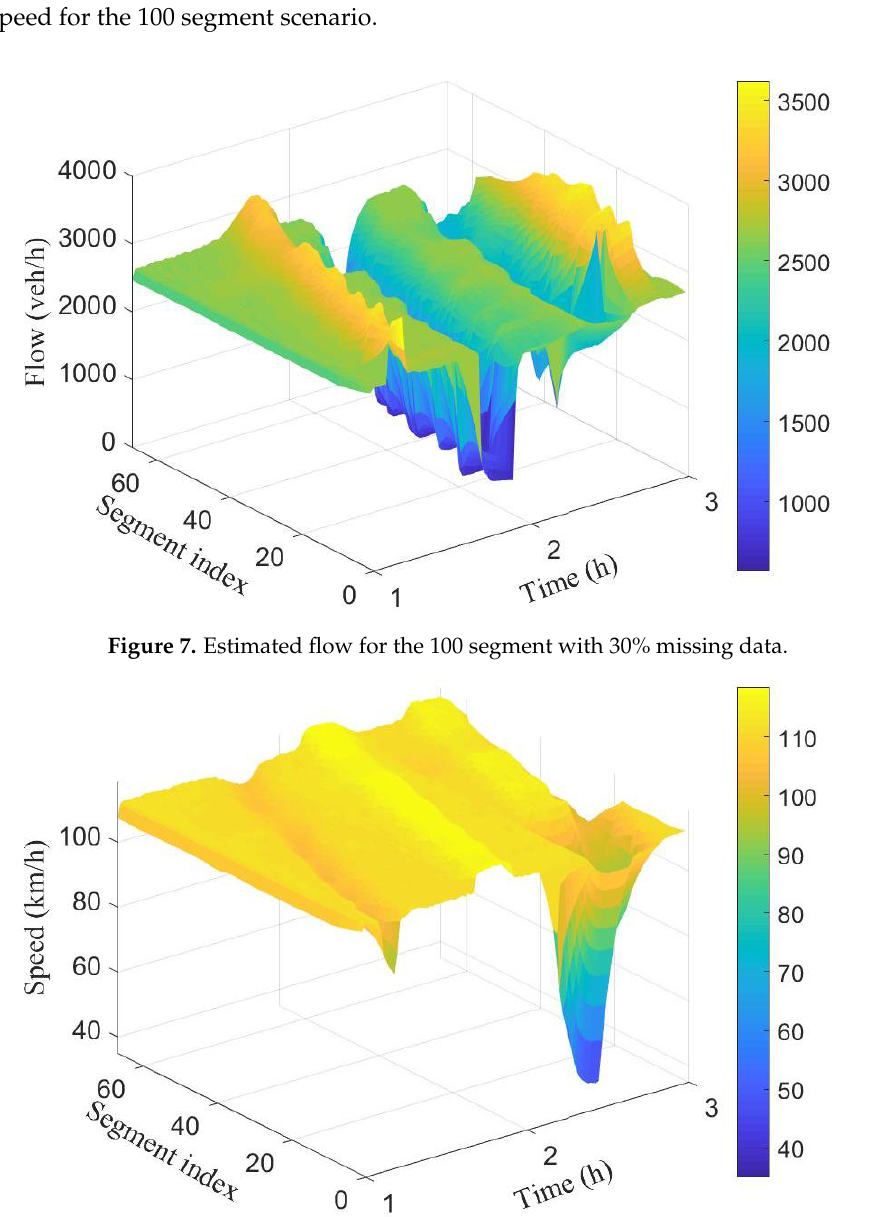
Figure 8. Estimated speed for the 100 segment with 30% missing